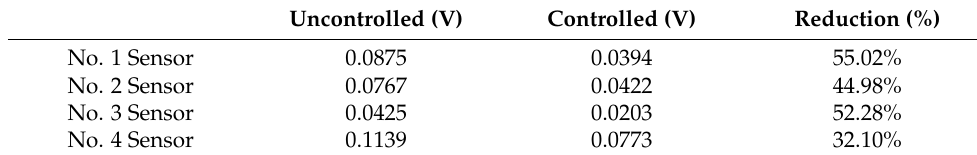
Figure 18. Sensor signals obtained by experiments (1 mV represents 0.1 m/s 2 ).